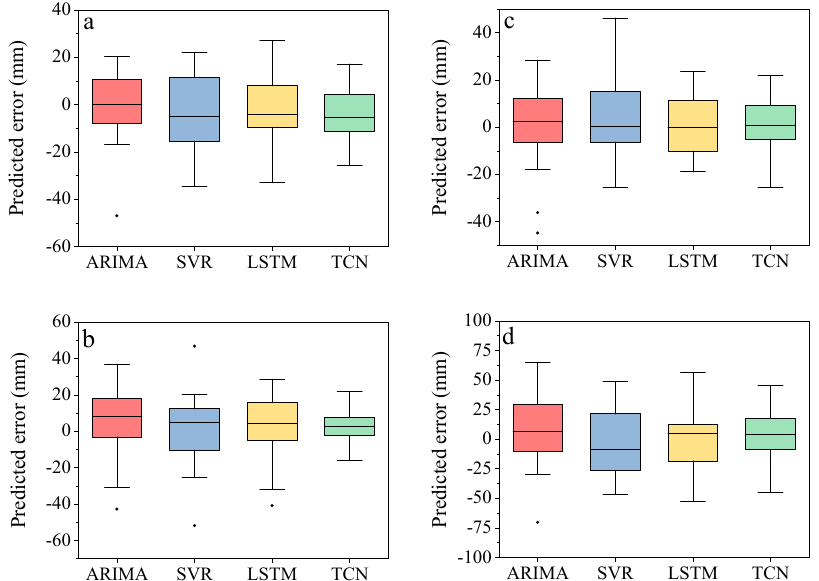
Figure 12. ( a ) Boxplots of absolute predicted errors for each model in ZG323; ( b ) boxplots of absolute predicted errors for each model in ZG324; ( c ) boxplots of absolute predicted errors for each model in ZG325; ( d ) boxplots of absolute predicted errors for each model in ZG326, the points represent the outliers.